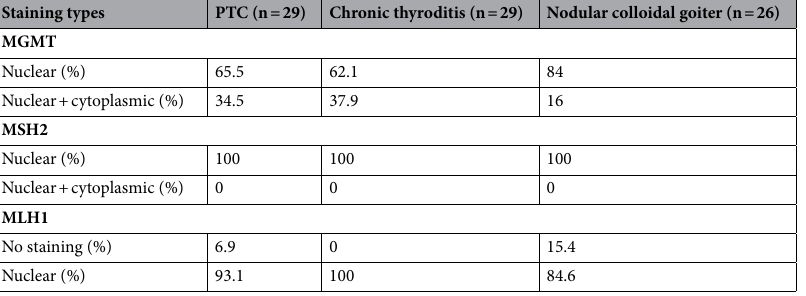
Table 5. Staining types of MGMT, MSH2, MLH1